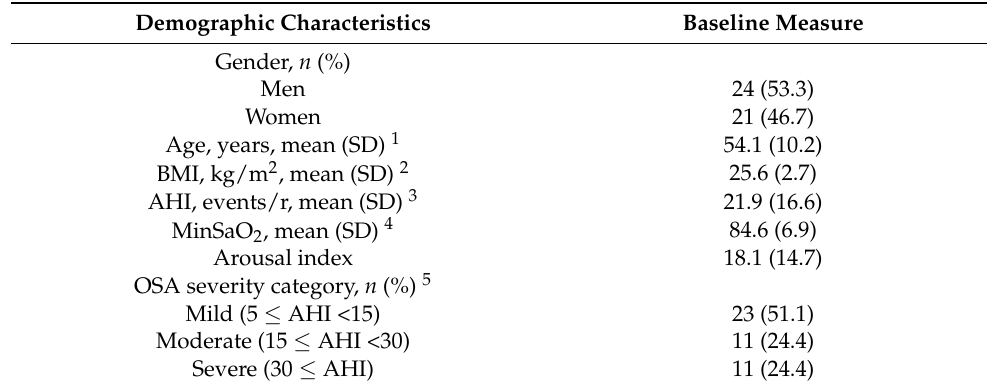
Table 1. Demographic characteristics of the 50 patients treated with the mandibular advancement device (MAD).